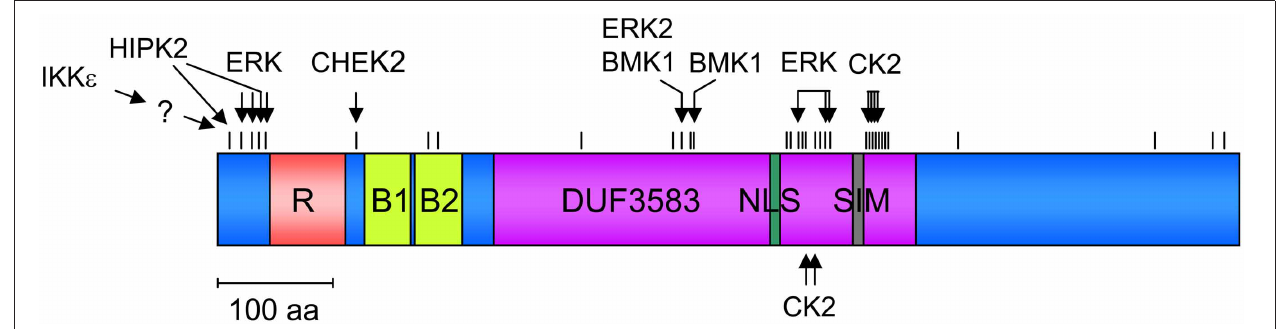
FIGURE 1 | Schematic display of the PML protein and its various domains. The distribution and clustering of phosphorylation sites is shown, the directly phosphorylating kinases and their upstream regulators are indicated.